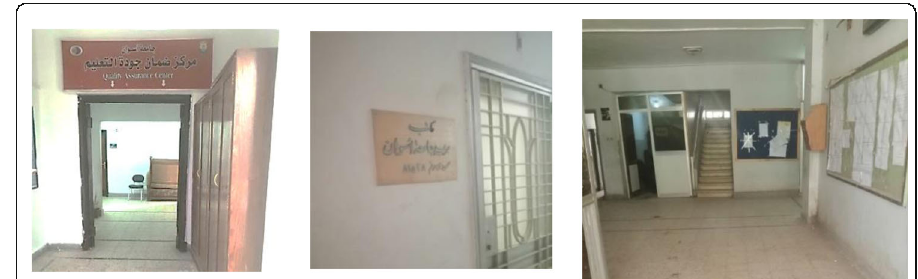
Fig. 15 The building lacks the Information System Design (2020)